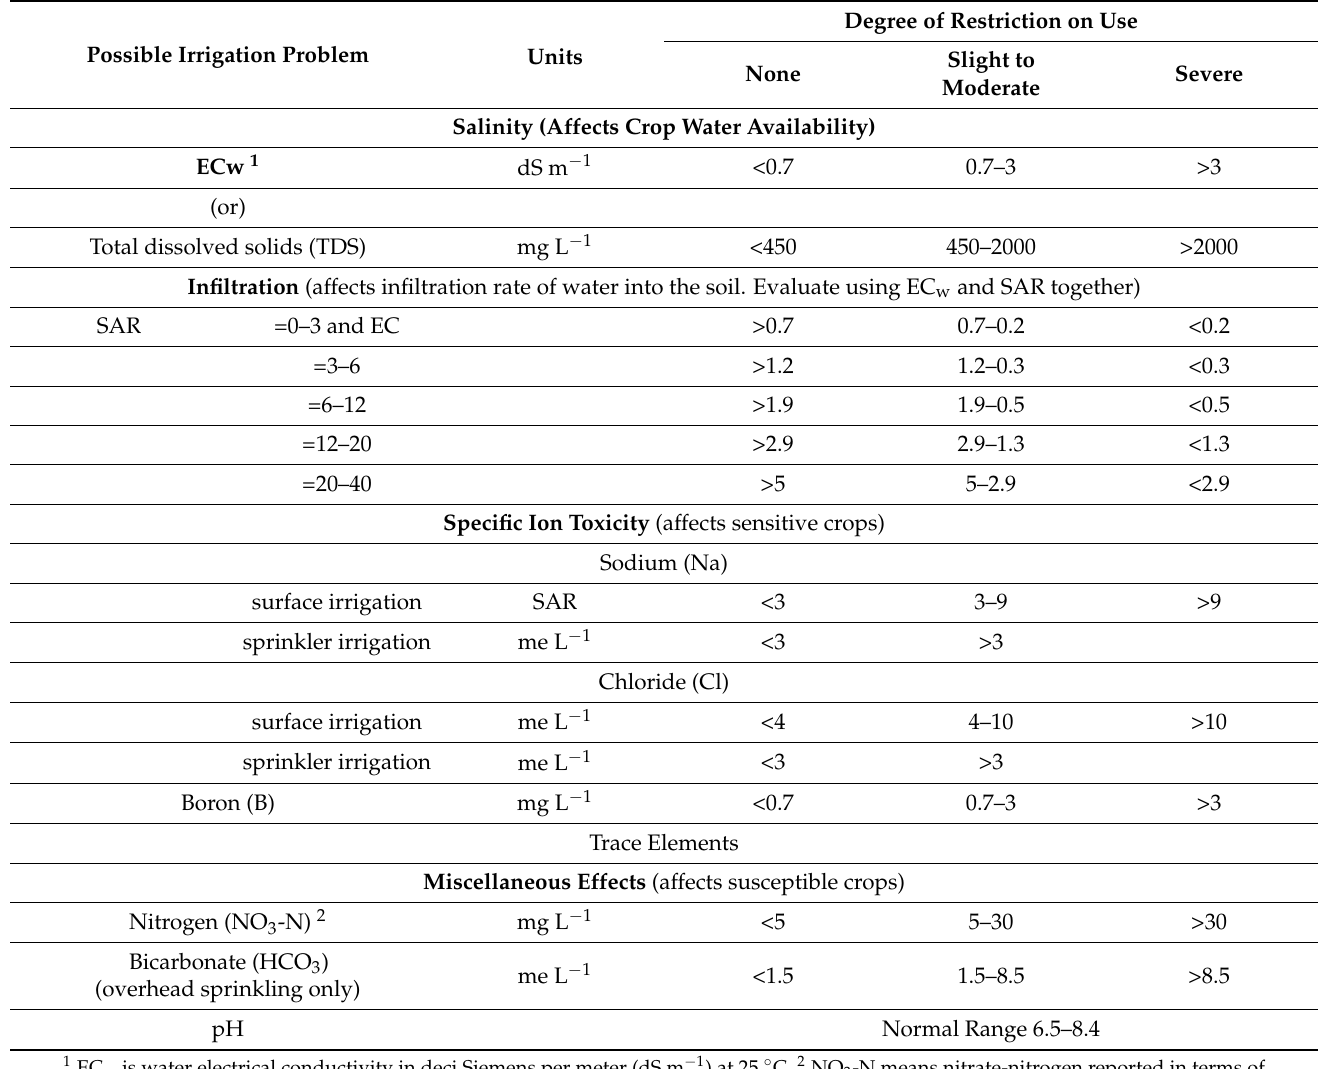
Table 4. FAO guideline for the quality of water used for irrigation